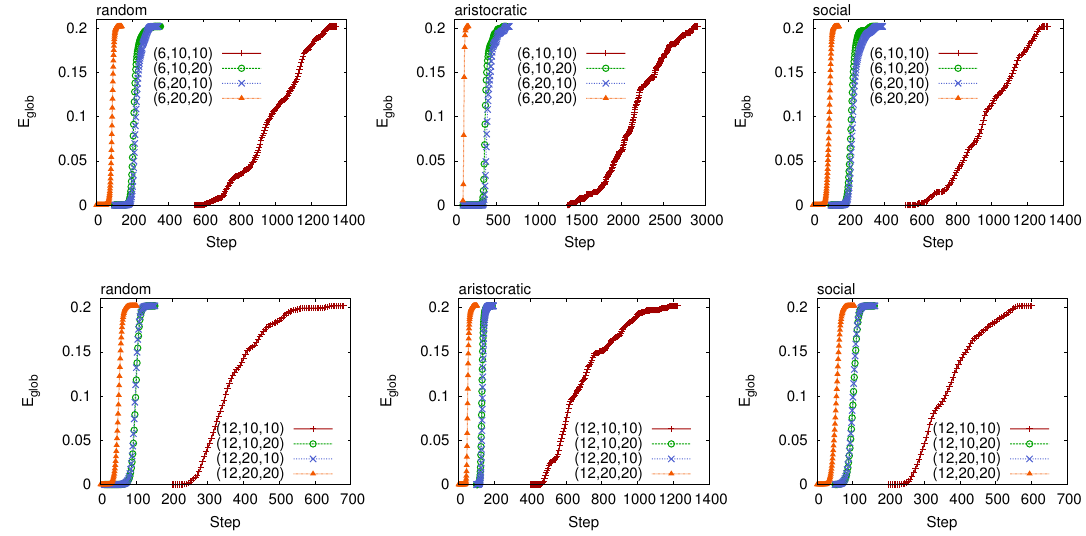
Figure 21. Accelerated analysis with mermaids fixing m = 6 and m = 12, random, aristocratic, and social rules, word of mouth model (for mermaids’ dynamics), VirtualTourist online social network.